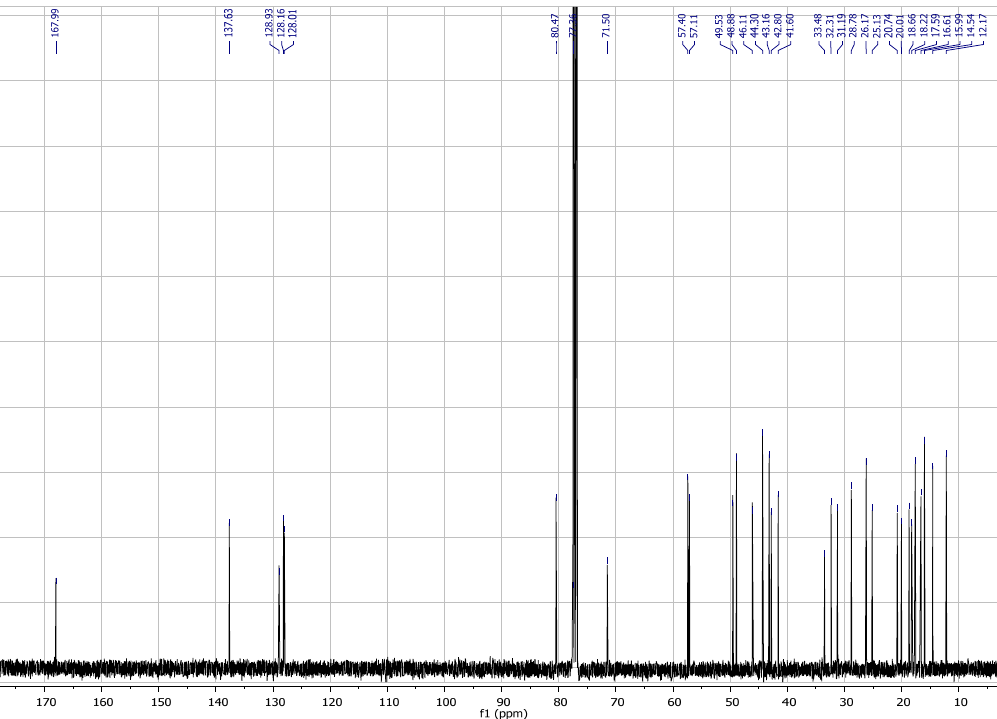
Figure A5. 13 C NMR spectrum (100 MHz, CDCl